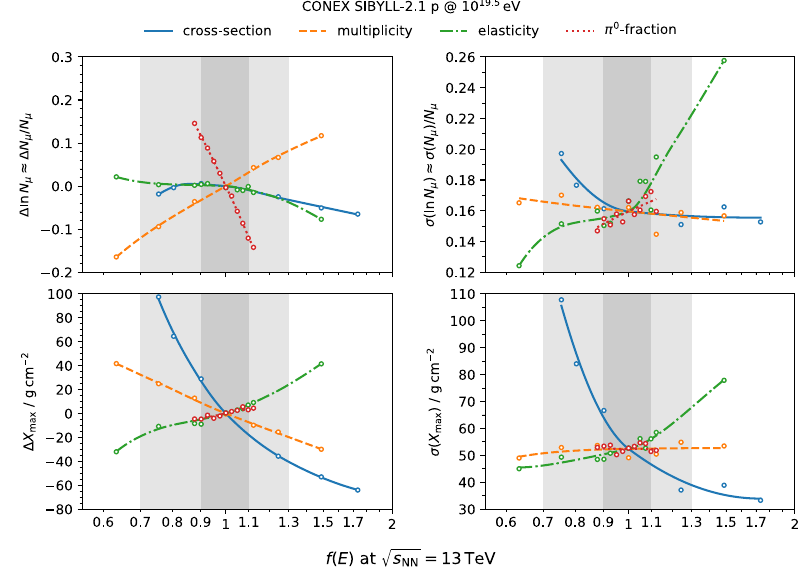
Figure 2. Impact of changing basic parameters of hadronic interactions at √ s NN = 13TeV and extrap- olating logarithmically (see Ref. [18] for details) on the means and standard deviations of the logarithm z mass distributions, as log ( E / 10 16 eV) to the ∆ z = z Figure 1. Linear fits of the form ∆ z = a + b of the muon number N µ (top row) and the depth X max of the shower maximum (bottom row) for a 10 · − described in Ref. [9]. Shown in the inset are the slope, b , and its deviation from zero in standard devia- 10 19 . 5 eV proton shower simulated with S ibyll 2.1 [1]. The shaded bands highlight a tions for an assumed correlation of the uncertainties within each experiment (for details see Ref. [10]). modification. The figure is an update of the original data from Ref. [18], taken from Ref. [8]. Examples of the fits are shown for a correlation of 0 . 0, 0 . 5, and 0 . 95 in varying shades of gray.